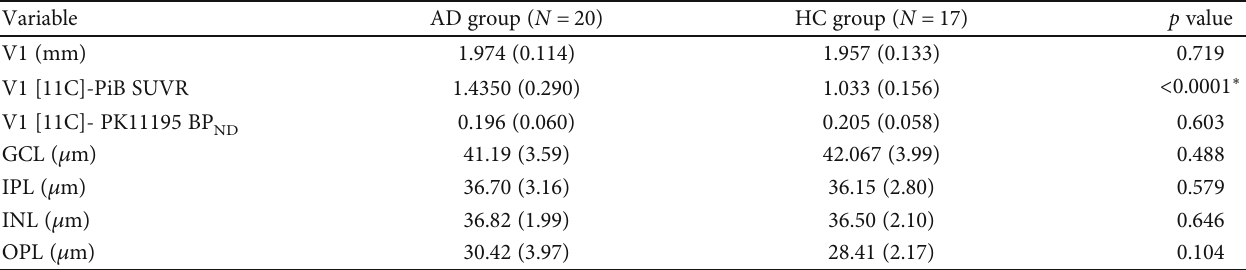
Table 3: Mean V1 thickness ( mean ± SD ), V1 [11C]-PiB SUVR ( mean ± SD ), V1 [11C]-PK11195 BP thicknesses ( mean ± SD ) per group. V1 [11C]-PiB uptake showed stark di ff erences in A β load.